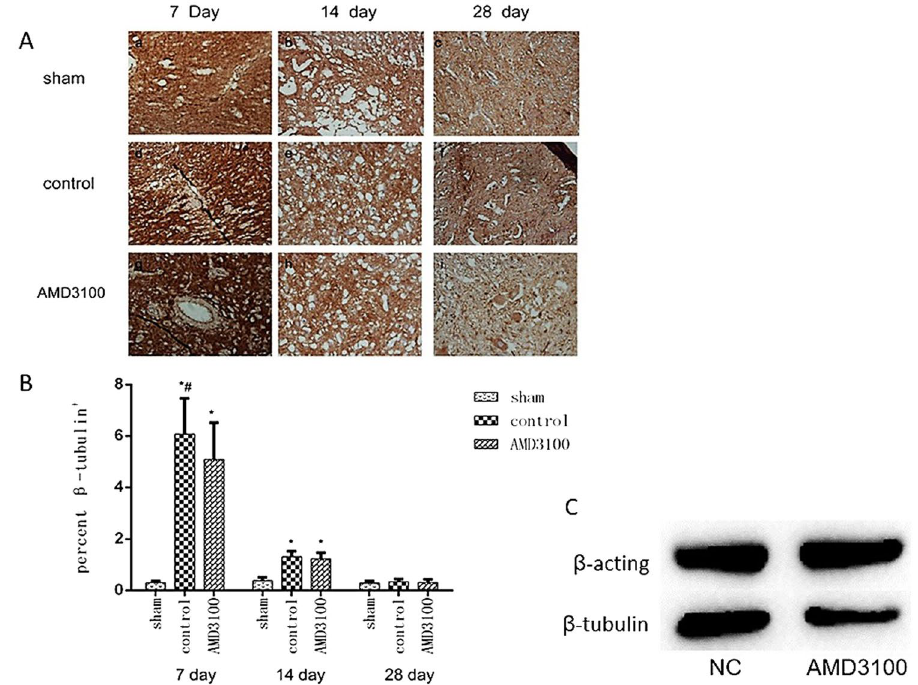
Figure 5. The expression of β -tubulin protein in neural stem cell after treated with AMD3100. ( A ) Representative images of IHC staining of β -tubulin in the three groups of rats ( × 400). It showed that the expression of β -tubulin increased on the 7th day and then decreased from the 7th to 28th day after surgery. ( B ) The expression of β -tubulin protein was lower in AMD3100 group of rats than that in untreated group after surgery. ( C ) The expression of β -tubulin protein in RASNF-01001 cells was significantly lower than that of control group after treated with AMD3100. ( * P < 0.05: untreated group vs. sham group, AMD3100 group vs. sham group; # P < 0.05: AMD3100 group vs. untreated